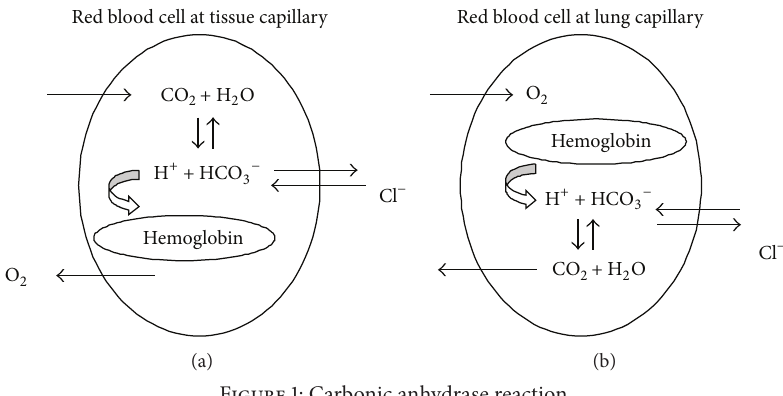
Figure 1: Carbonic anhydrase reaction. Table 1: Acute conditions in which sodium bicarbonate therapy has not improved